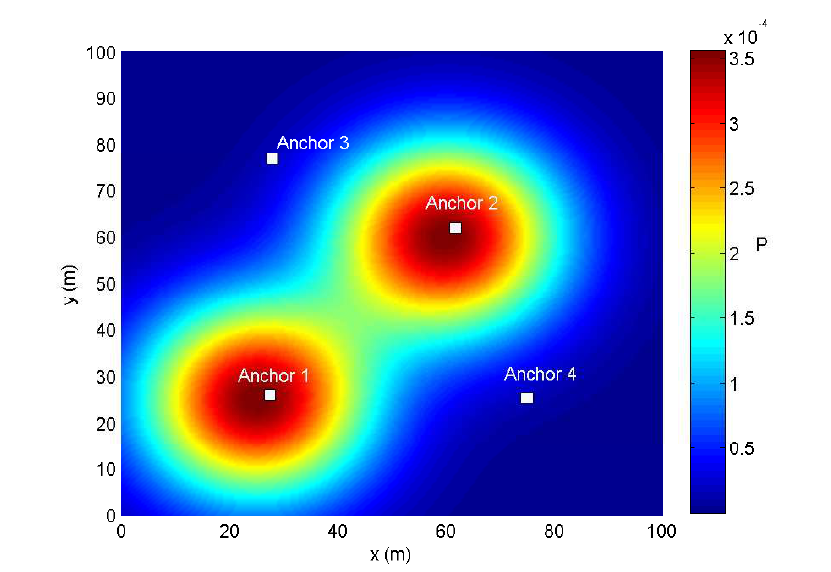
Figure 2. The WSNs consists of four anchor nodes, and the service area is the 100 m × 100 m square region and two special focus areas with a higher value of the PDF. The different colors represent different probabilities as indicated on the